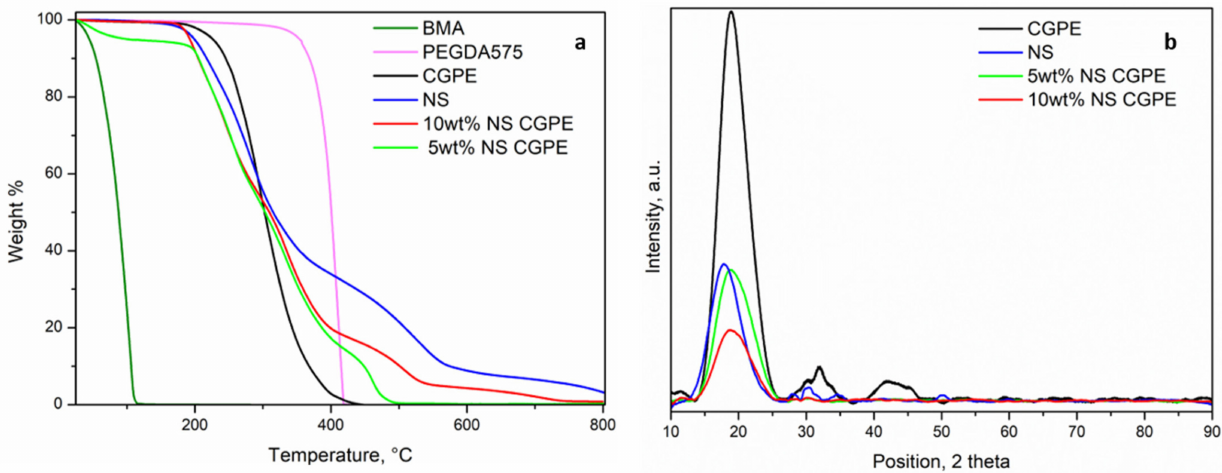
Figure 3. TGA traces of the CGPE precursors and the different CGPEs prepared ( a ). XRD patterns of NS, CGPE without NS, with 5 wt% NS, and 10 wt% NS ( b